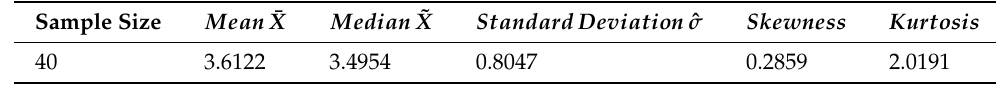
Table 5. Summary statistics related to data-I.